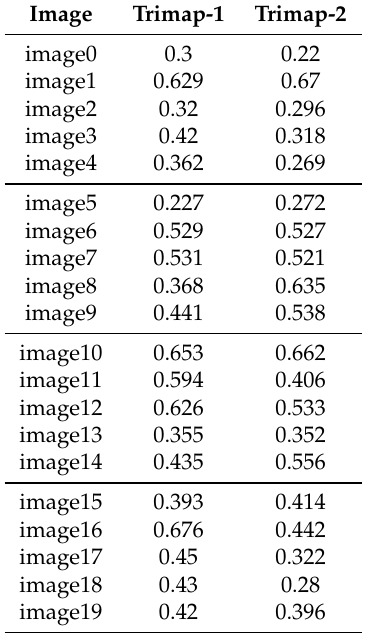
Table 5. Experiment 2: IOU statistics of the 20 test images. The trimap-1 and trimap-2 obtained by dilating the groundtruth matte with different expansion sizes.